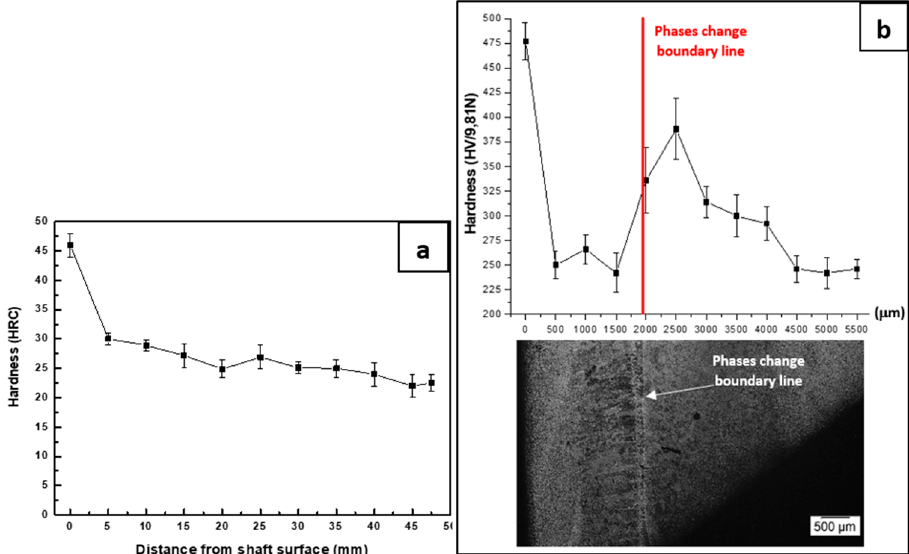
Figure 12. ( a ) Hardness profile of the shaft cross-section; ( b ) distribution of the microhardness along the hardened surface layer of the shaft.